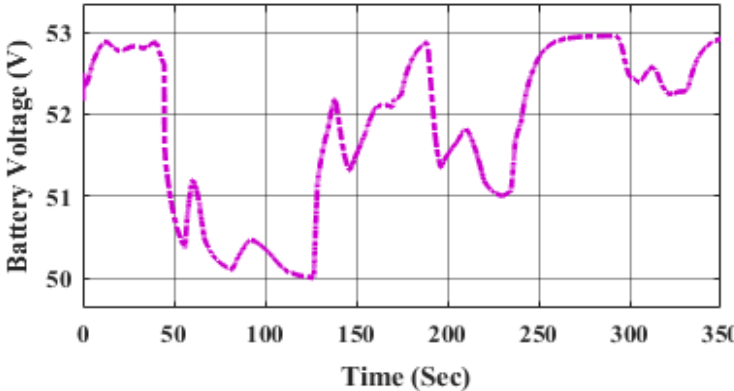
Figure 20. Battery voltage – time response.